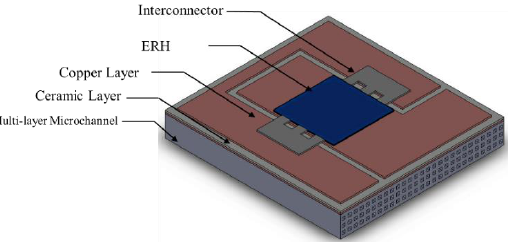
Figure 5. The schematic of the multi-layer microchannel heat sink and CPV receiver. Table 5. The CPV receiver dimensions and its material thermophysical properties [45].